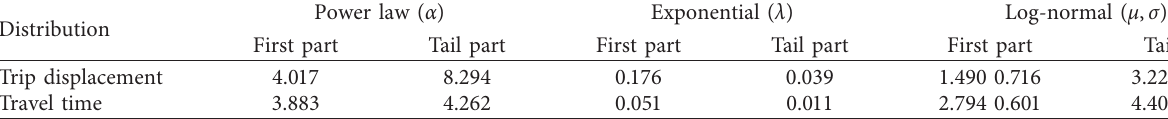
Table 1: Estimated parameters for fitting the distributions of trip displacement and travel time.